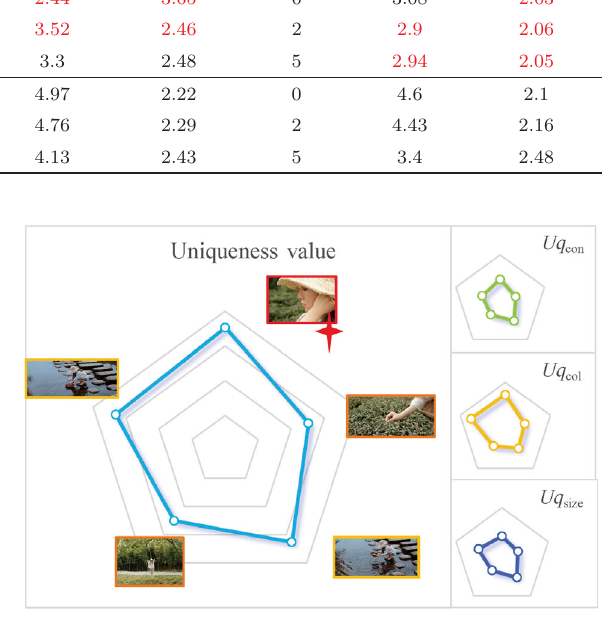
Fig. 6 Uniqueness value distribution of the page with five images. The left part is the distribution of comprehensive uniqueness value and the right part are the three sub-distributions of content ( Uq con ), color ( Uq col ), and size ( Uq size